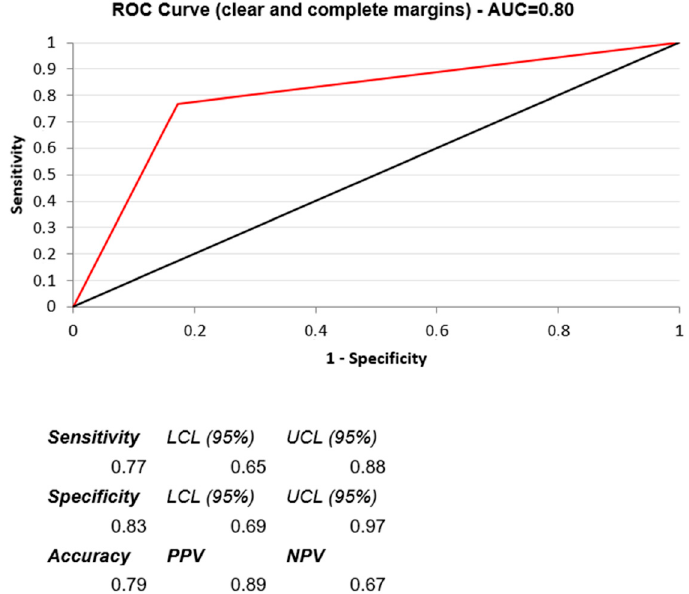
Figure 2. ROC curve for the presence of clear and complete margins, which showed the best predictive value for CR+: AUC = 0.80, sensitivity 0.77, specificity 0.83, PPV 0.89, and NPV 0.67. Table 1. Univariate analysis and binary logistic regression (BLR) of demographics, clinical data, and lesion features. CR+ vs. CR − lesions.